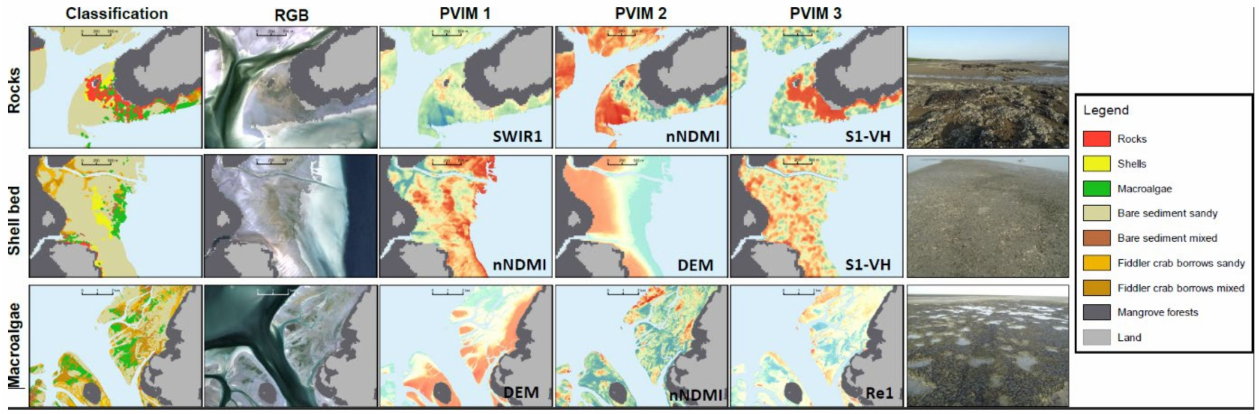
Figure 5. Detailed view of example areas for rocks, shell beds, and macroalgae habitats, with visual comparison to an equivalent RGB image produced from the same Sentinel-2 image for which predictions were conducted to produce the final map. The three most important predictors for each habitat type are shown in order of importance according to the permutated variable importance measure (PVIM 1, PVIM 2, and PVIM 3), with a spectral colour pallet ranging from blues for smaller values, yellows for intermediate values, and orange-red for higher values. Last column presents example images from the